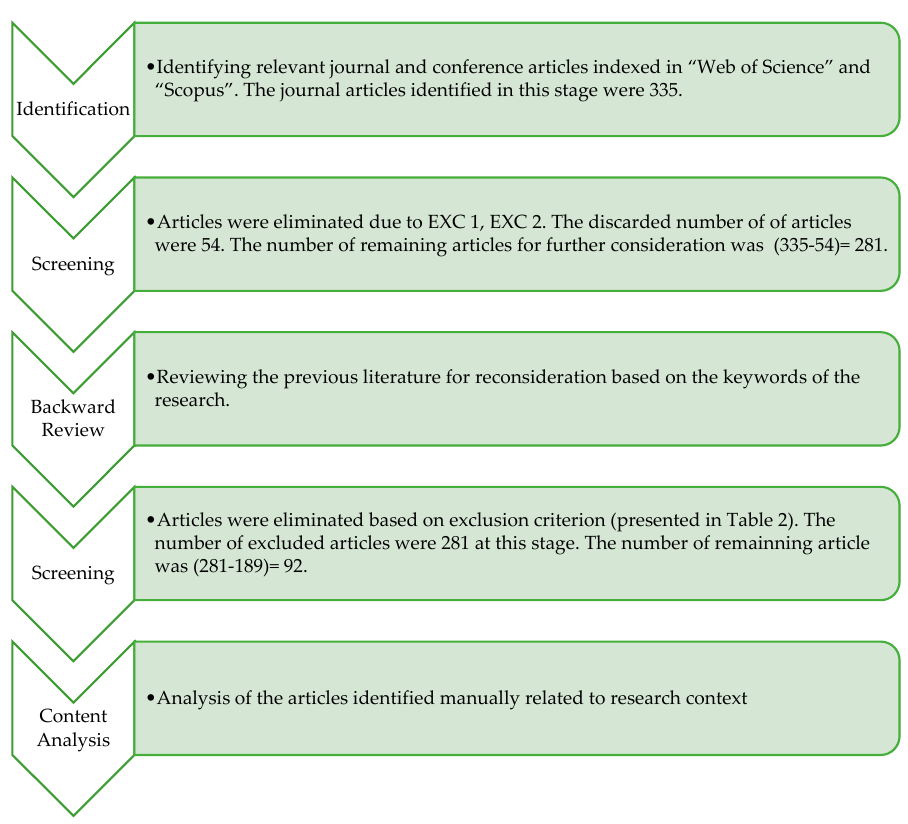
Figure 1. The methodological steps followed in the research.